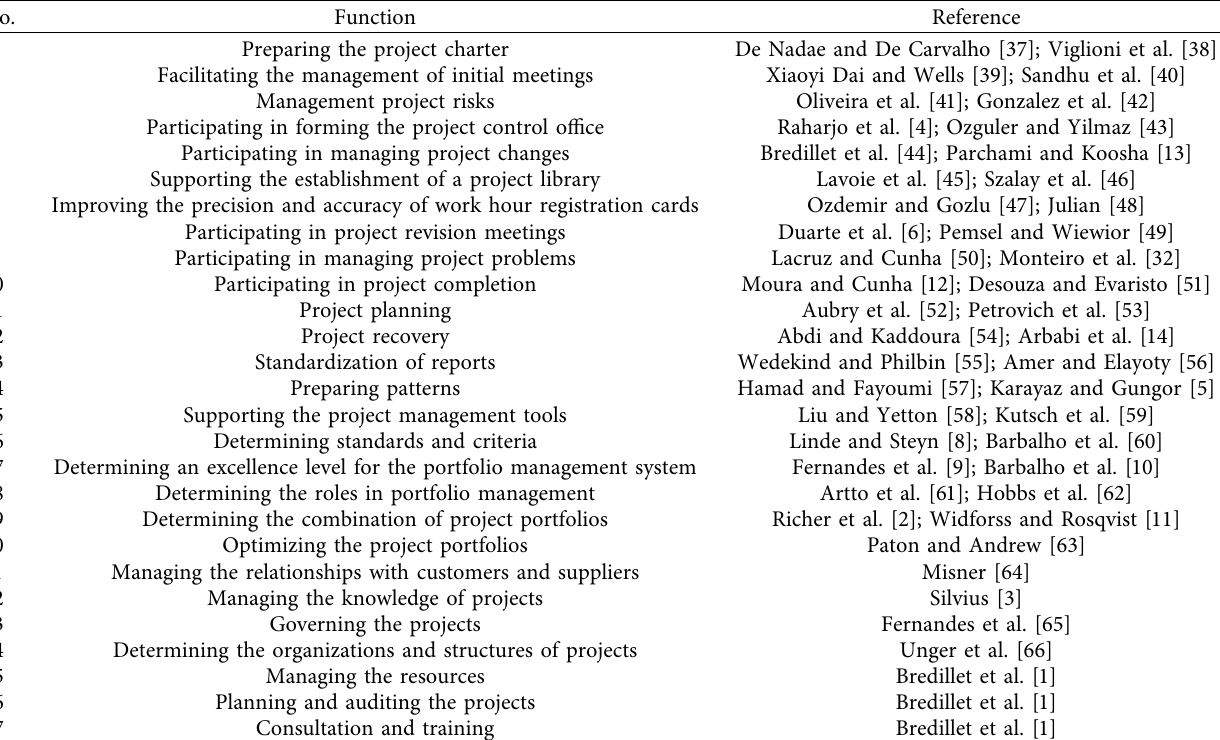
Table 3: General PMO functions identified through the opinions of different